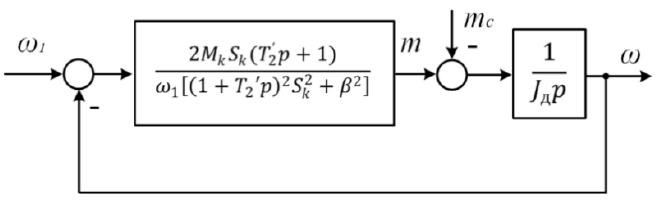
Figure 8. IMD equivalent circuit [25,28,29].